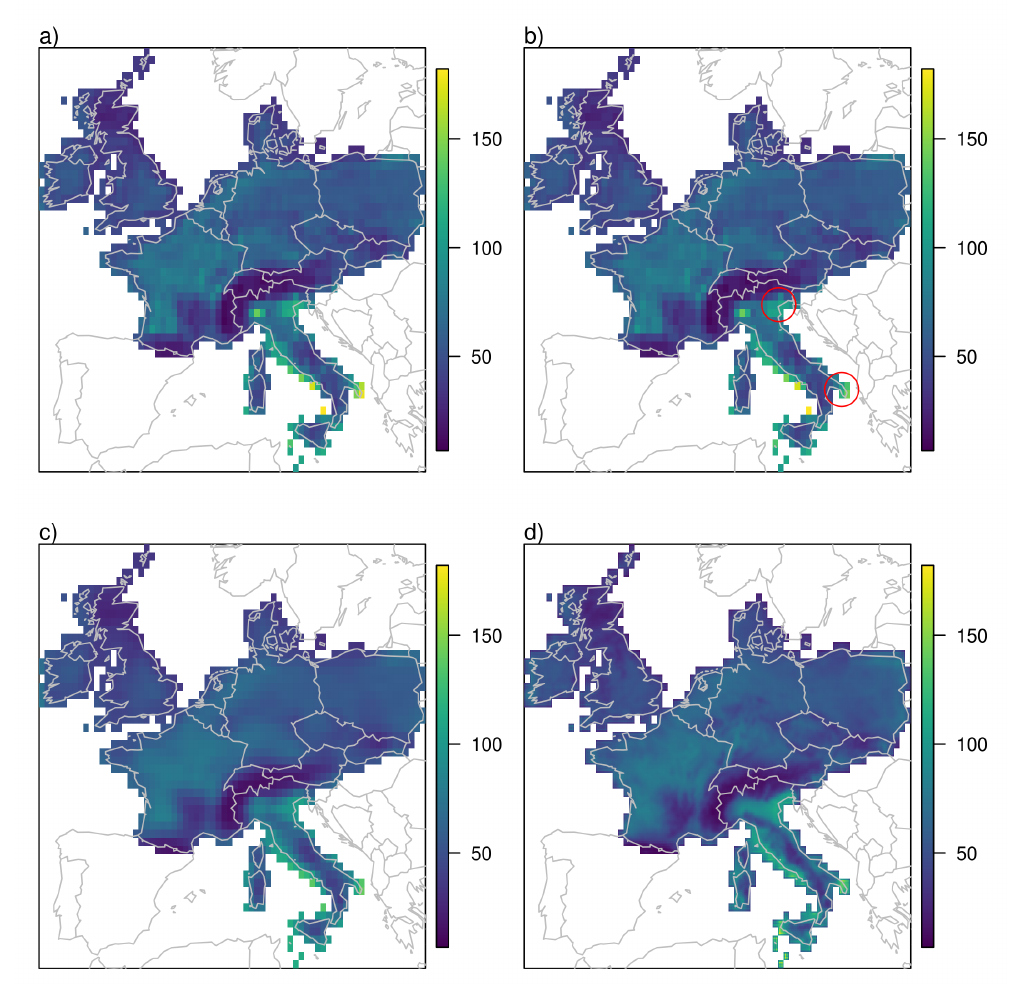
Figure 8. Local tornado occurrence rate of the Risk Management Solutions (RMS) Severe Convective Storms Model per 100 years and 10,000 km 2 . In all four cases the rates are scaled to produce an average of 181 tornadoes per year across the entire domain. Panel ( a ) rescaled output of the GLM, ( b ) including corrections at two locations where the frequency of SBCAPE >1000 J kg − 1 in climate forecast system reanalysis (CFSR) seems unrealistically high compared to ERA, ( c ) following smoothing between neighbouring grid cells and ( d ) final occurrence rate after downscaled to 0.1 ◦ using an elevation weighting. Red circles highlight the two areas where local corrections are applied in panel ( b